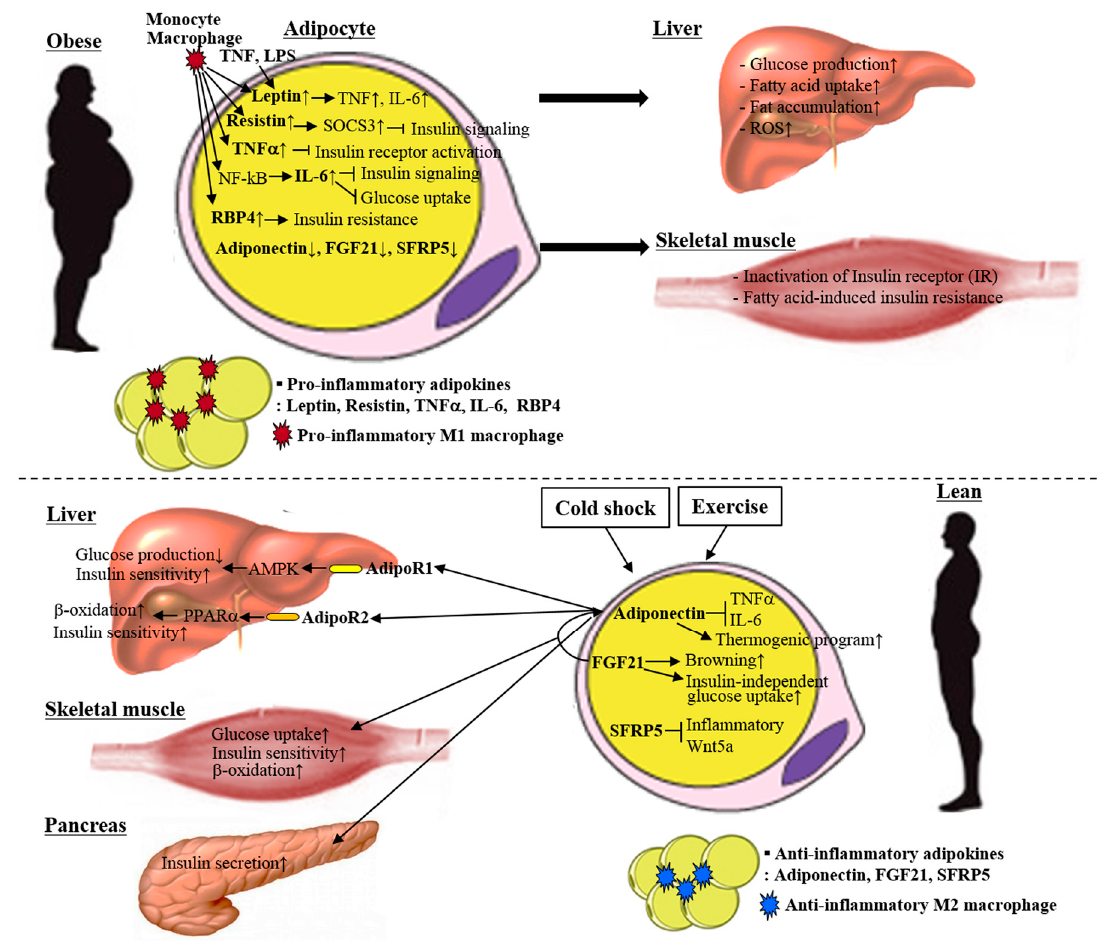
Figure 3. Adipokines are characterized by both pro-inflammatory and anti-inflammatory activities. Obesity increases the production of pro-inflammatory cytokines such as leptin, resistin, tumor necrosis factor α (TNF α ), interleukin 6 (IL-6) and retinol binding protein 4 (RBP4) from adipose tissue. These cytokines are associated with the development of insulin resistance and metabolic abnormalities in local and peripheral tissues. On the other hand, anti-inflammatory adipokines (including adiponectin, FGF21 and SFRP5) can be stimulated by cold shock and exercise, including UCP1 expression in WAT and promoting the browning of WAT (beige). Anti-inflammatory adipokines for metabolic adaptation act systemically in an endocrine manner. They mitigate impaired lipid and glucose metabolism in the liver, muscle and pancreas, leading to improved whole-body insulin sensitivity levels. Therefore, understating the mechanism by which the balance between pro-inflammatory and anti-inflammatory adipokines can be maintained would provide a clue for researchers looking to prevent obesity and related metabolic diseases. LPS: lipopolysaccharide; SOCS3: suppressor of cytokine signaling 3; SFRP5: secreted frizzled-related protein 5; AdipoR1: adiponectin receptor 1; AdipoR2: adiponectin receptor 2.